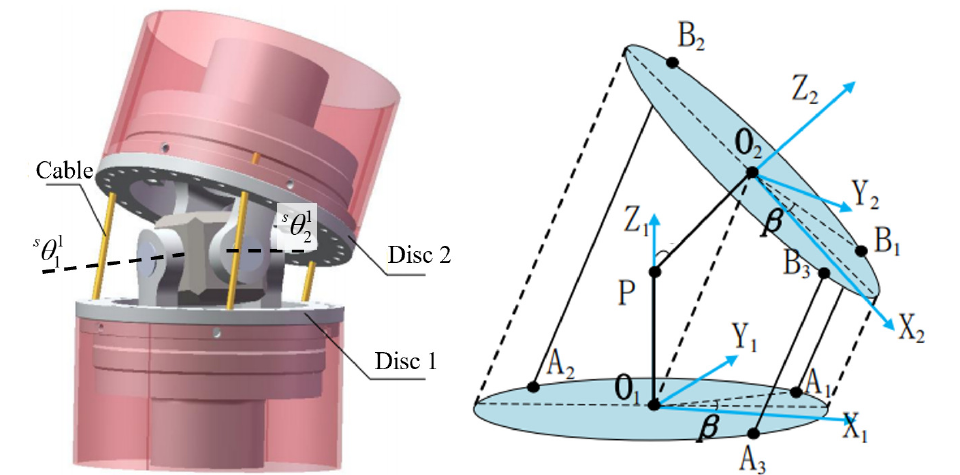
Figure 3. The kinematics relationship between the first cross-axis joint and the first group of